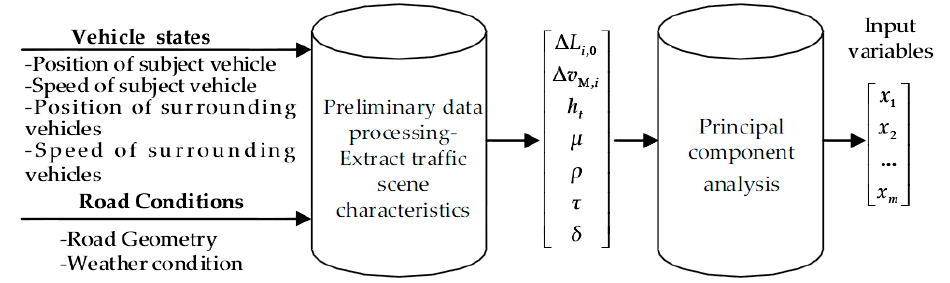
Figure 2. The detailed data processing of data processing program.